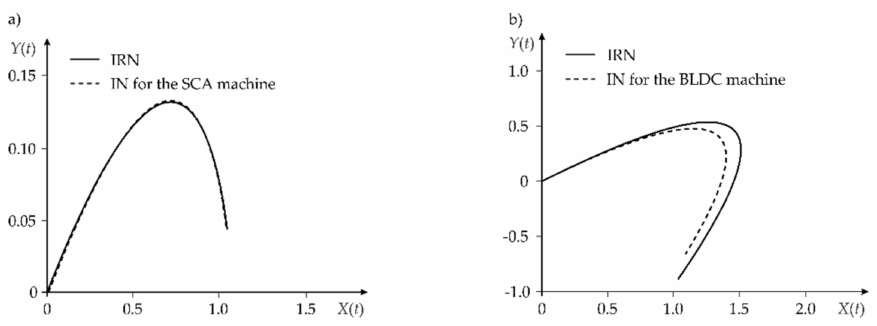
Figure 9. The shapes of the nets obtained for both machines: ( a ) IN; ( b ) IRN. The shapes of the IN obtained for the SCA and BLDC machines match the correspond- ing IRNs with the mse equal to 0.1527 and 1.6437,